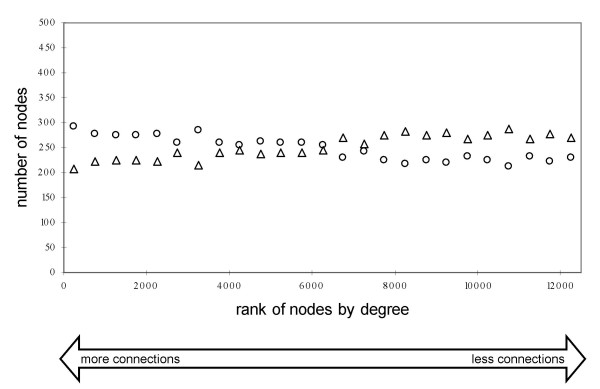
The number of duplicate genes and singletons in every 500 genes ranked by degree. Duplicate genes are marked by triangles and singletons are marked by circles. The genes with the highest degree are shown at the left side of the figure.